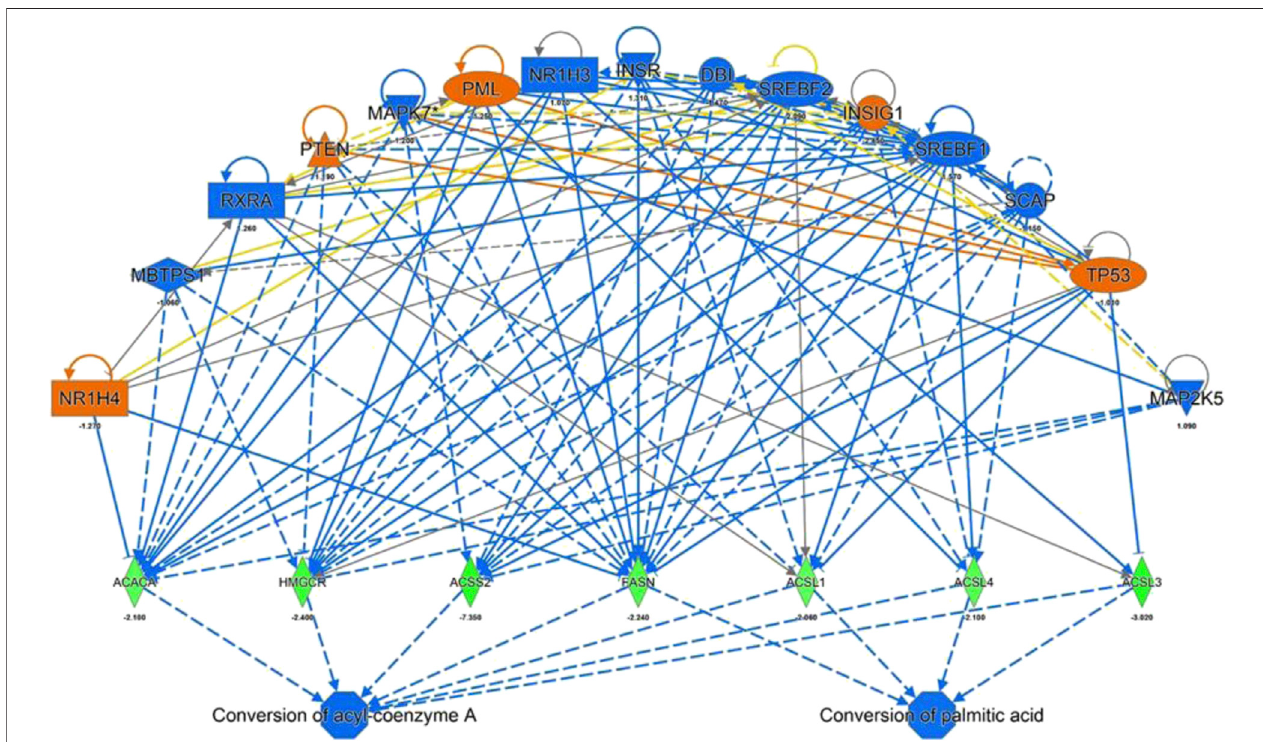
FIGURE 4 | IPA Upstream Regulators Analysis for identi fi cation of upstream regulators that may be responsible for changes in gene expression observed for ACACA, HMGCR, ACSS2, FASN, ACSL 1,3 and 4 (predicted activation (orange) predicted inhibition (blue) of the regulators leads to a decreased expression (green)).